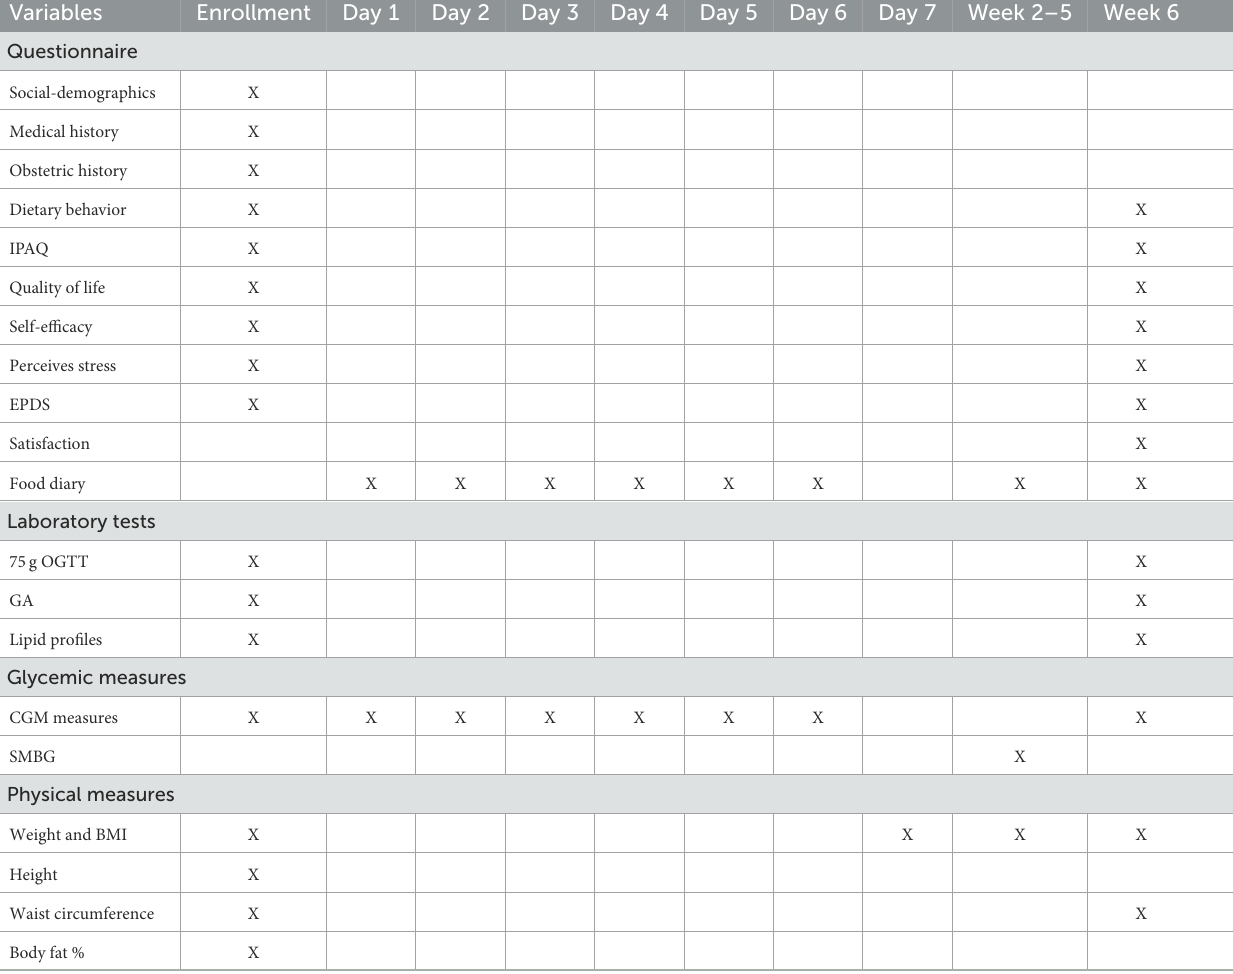
TABLE 3 Data collection at evaluation of time